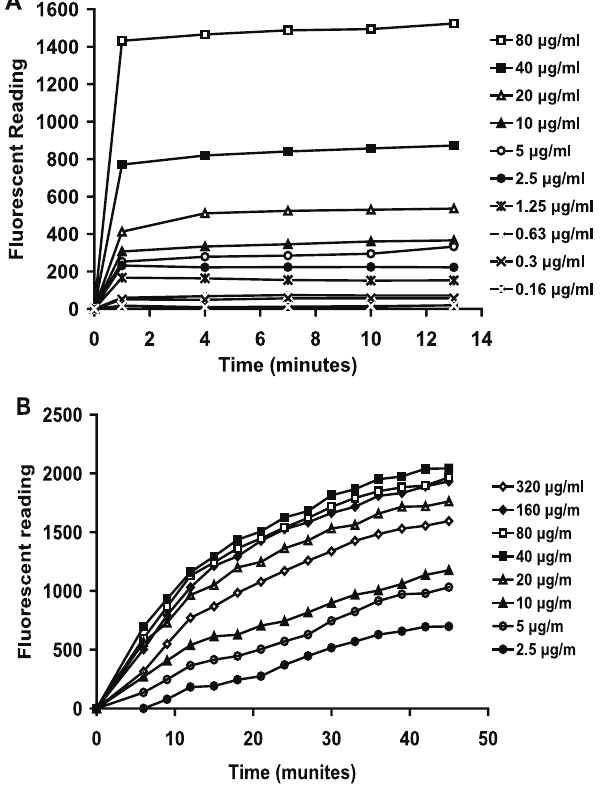
Figure 5. HT61-induced cytoplasmic membrane permeabiliza- tion determined by the DiSC3(5) assay. Non-multiplying and log phase MSSA were incubated with DiSC3(5) to a final concentration of 0.4 mM until no more quenching was detected, which was followed by addition of 0.1 M KCl. Different concentrations of HT61 were incubated with non-multiplying MSSA (A) and log phase MSSA (B). The changes in fluorescence were monitored at various time points. The data was confirmed in two independent experiments.